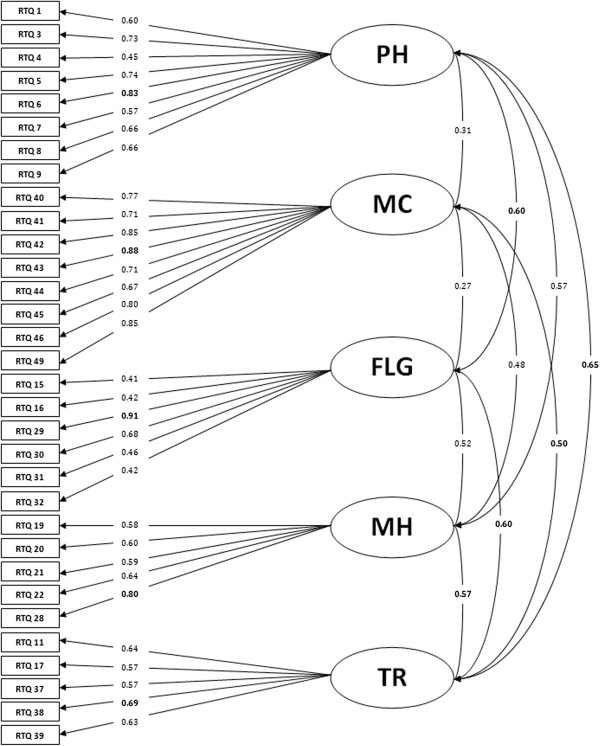
Confirmatory Factor Analysis of the 2nd version of the RTQ.